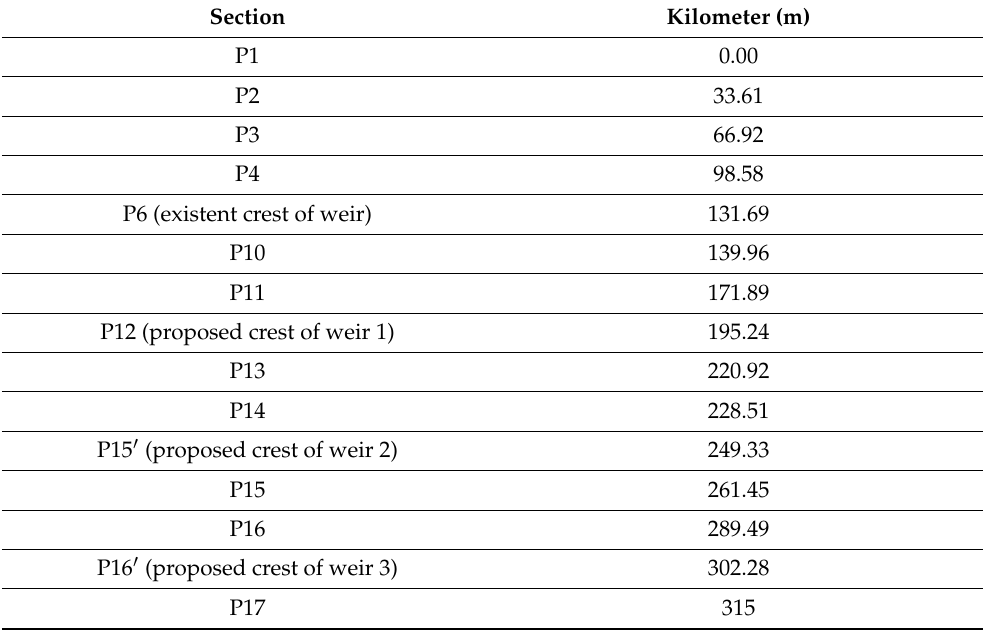
Table 1. Mileage of the main sections of the